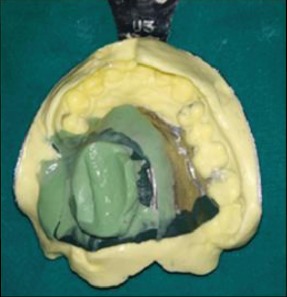
Pick-up impression.